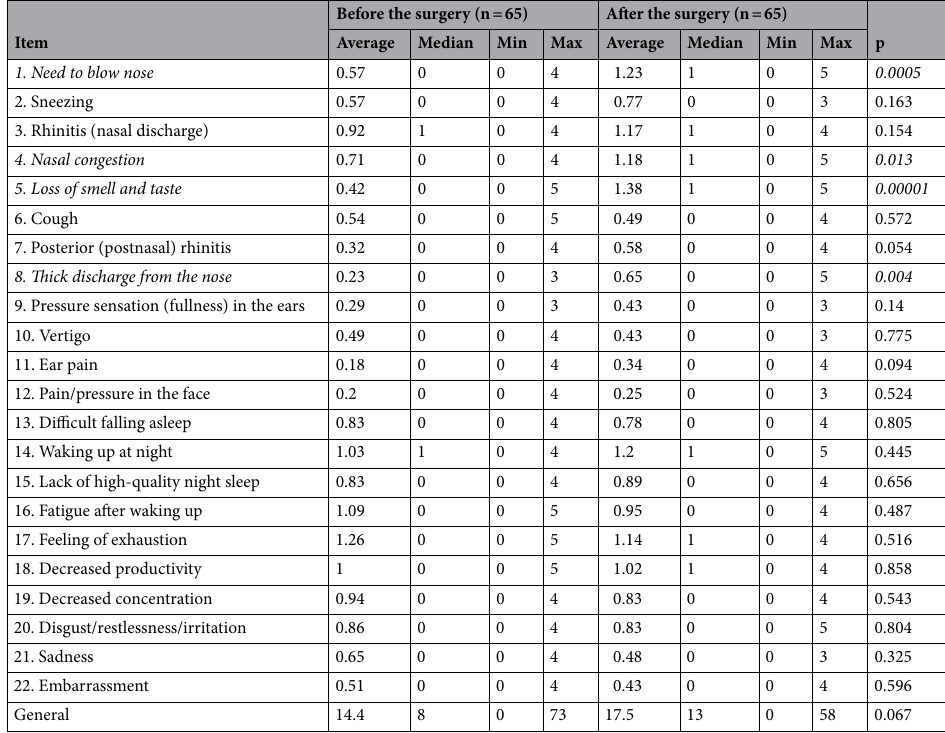
Table 2. SNOT-22 scores before the surgery and 6 months after the surgery. Items with statistically significant change are marked in italics.